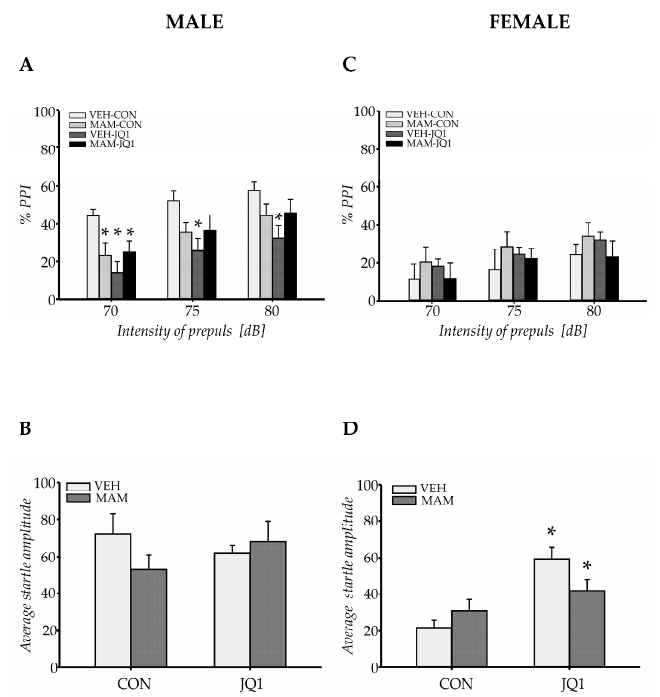
Figure 2. The effects of an adolescent JQ1 administration on sensorimotor gating (% of pre-pulse inhibition, PPI) in the acoustic startle response test ( A , C ) and on the average amplitude of startle ( B , D ) in the MAM-E17 model of schizophrenia. The rats (males: A , B and females: C , D ) were exposed to JQ1 or vehicle (CON) in early adolescence (P23–P29), and the analyses were performed in rats at P70. Each data point represents the mean ± SEM; n = 12 per group * p < 0.05 vs . VEH-CON (two-way repeated measures ANOVA ( A , C ) or two-way ANOVA ( B , D ) followed by a Tukey test).